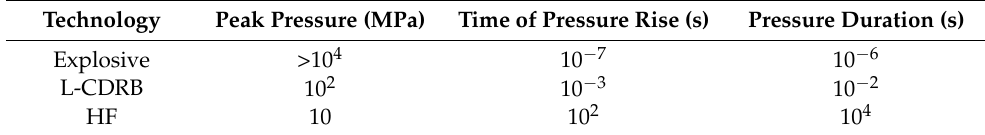
Table 1. Loading parameters of different rock-breaking